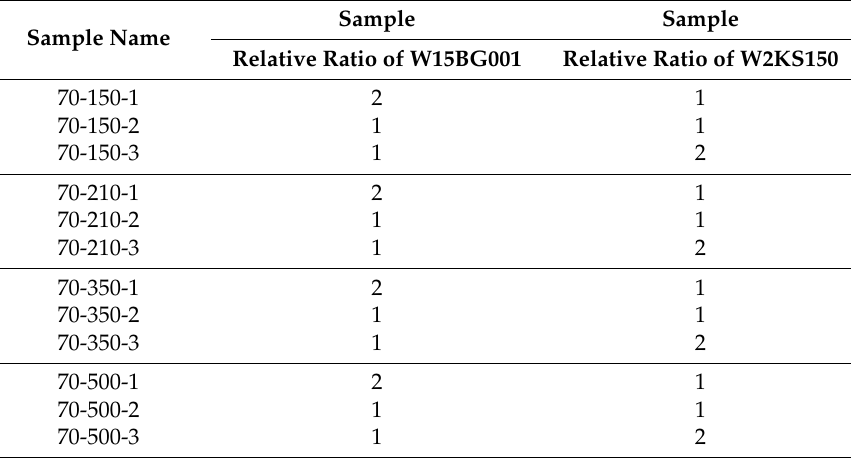
Table 2. Characteristics of polystyrene latex particle mixtures used in this